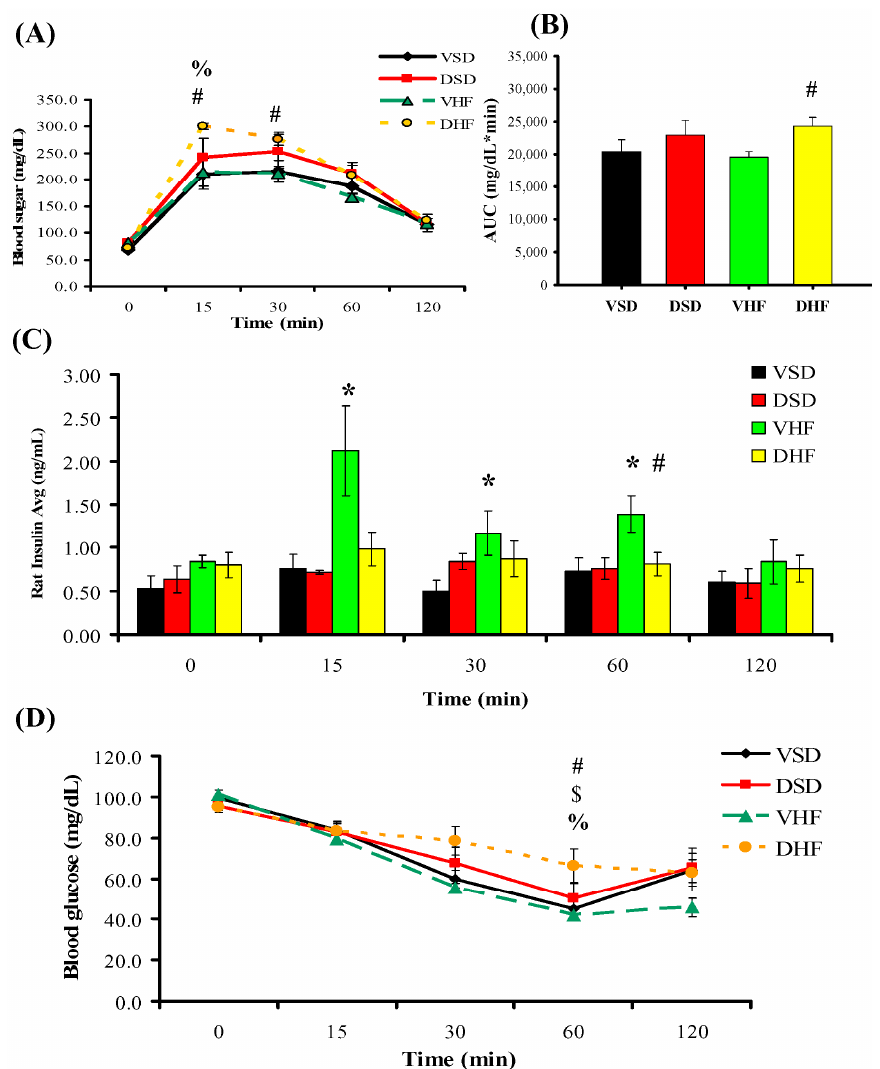
Figure 2. Glucose and insulin levels post-stimulation tests: ( A ) intraperitoneal glucose tolerance test; ( B ) glucose area under curves (AUC); ( C ) insulin levels; and ( D ) insulin tolerance test. Data were analyzed by repeated measures ANOVA with post hoc least significant difference testing. *, VSD vs. VHF, p < 0.05; #, VHF vs. DHF, p < 0.05; %, VSD vs. DHF, p < 0.05; $, DSD vs. DHF, p <